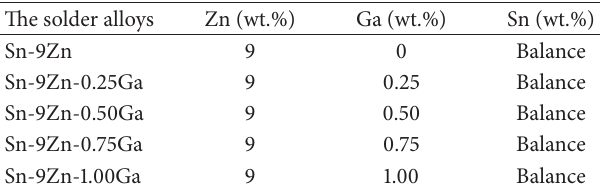
Table 1: The chemical composition of the solder